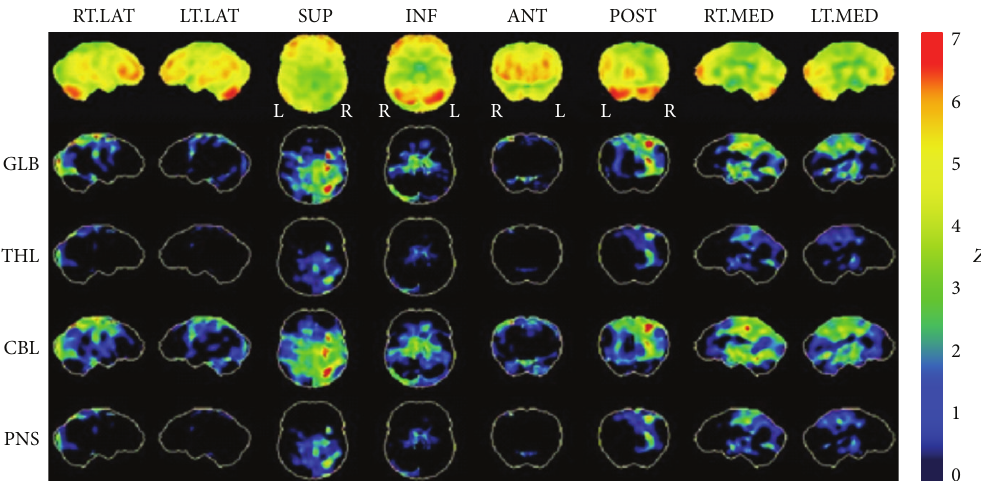
Figure 5: Single-photon-emission computed tomography (SPECT). Cerebral perfusion scan 99mTc HMPAO Z-score reconstructed images. Statistical mapping carried out using the NeuroSTAT programme. Demonstrating asymmetrically decreased activity involving the parietal, occipital, and, to a lesser extent, temporal lobe cortex, greater on the right than on the left. RT.LAT = right lateral; LT.LAT = left lateral; SUP = superior; INF = inferior; ANT = anterior; POST = posterior; RT.MED = right medial; LT.MED = left medial. GLB = global; THL = thalamus; CBL = cerebellum; PNS =